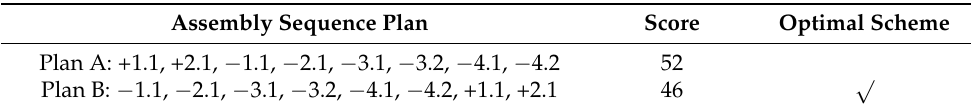
Table 9. System generated assembly sequence